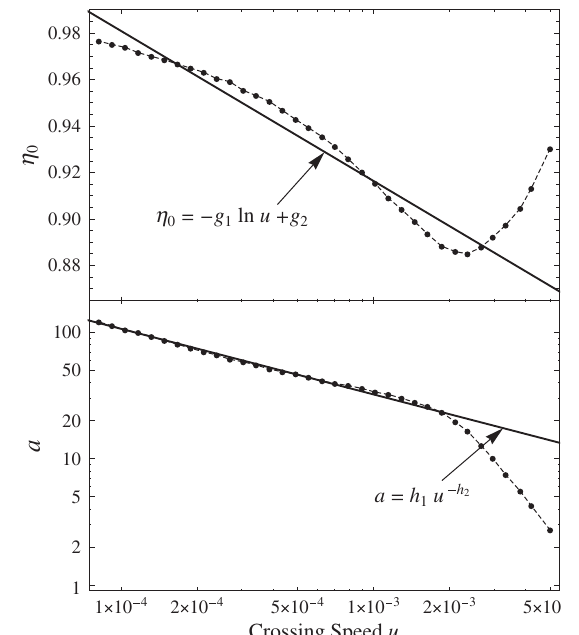
FIG. 18. Fitting constant estimation. The parameters (cid:3) 0 and a in Eq. (3) are evaluated from WARP simulation data as a function of u . The solid lines correspond to the simple fitting functions defined by Eq. (4).